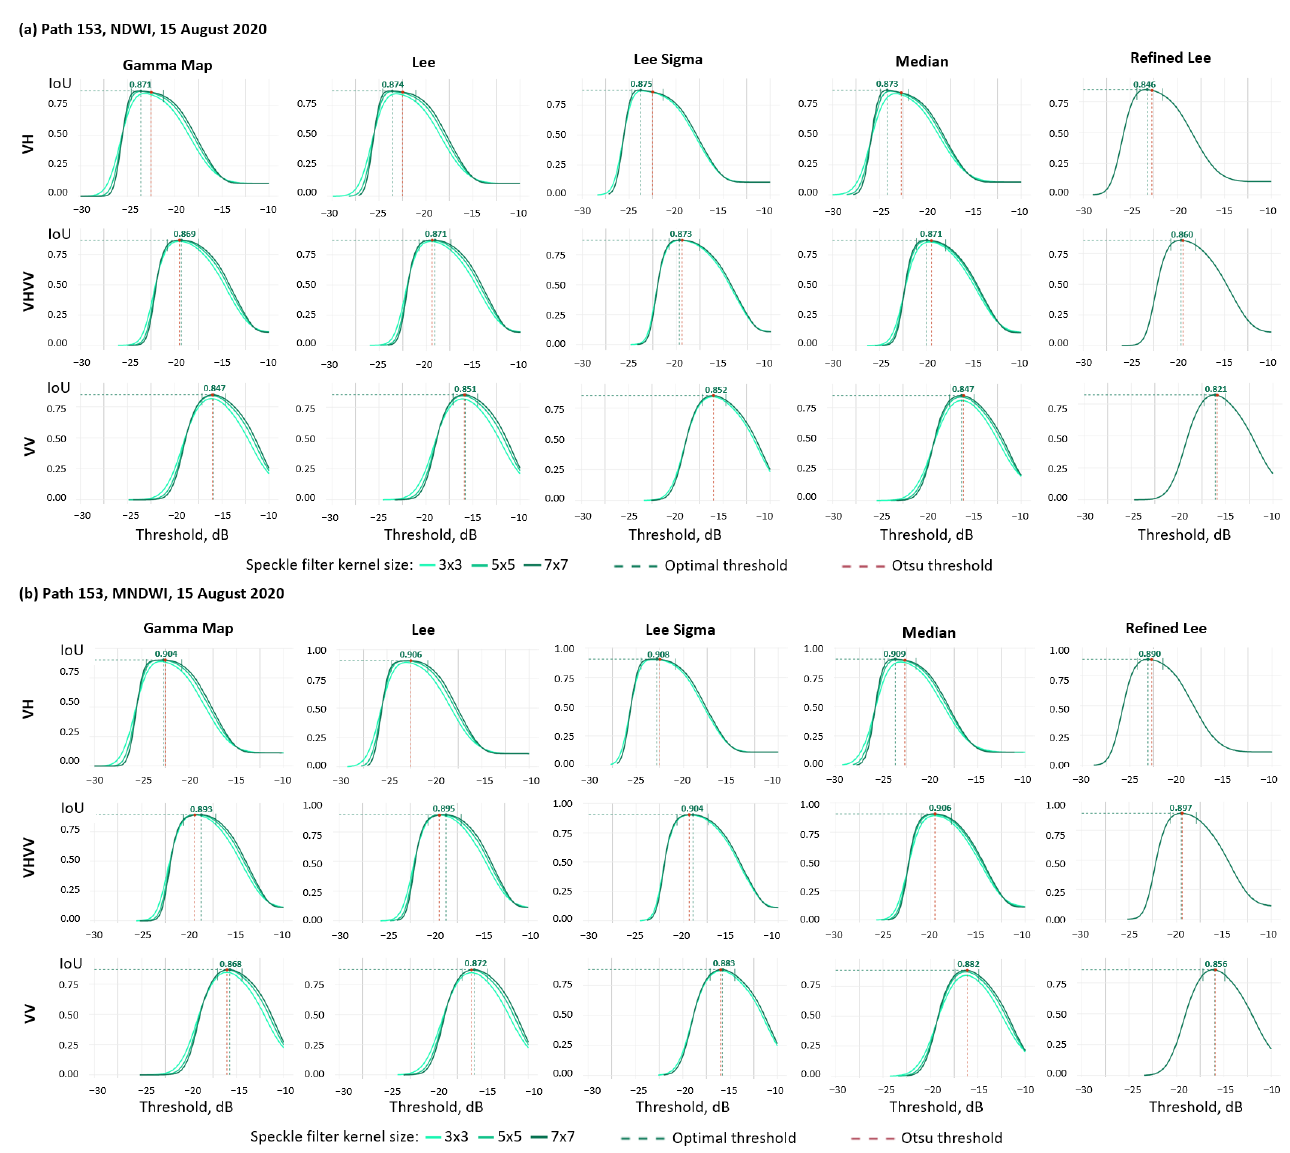
Figure 12. Comparison of the thresholds determined using the proposed method and the Otsu method on the plots of mask similarity ( IoU ) versus backscatter threshold: ( a ) 15 August 2020 NDWI and ( b ) 15 August 2020 MNDWI